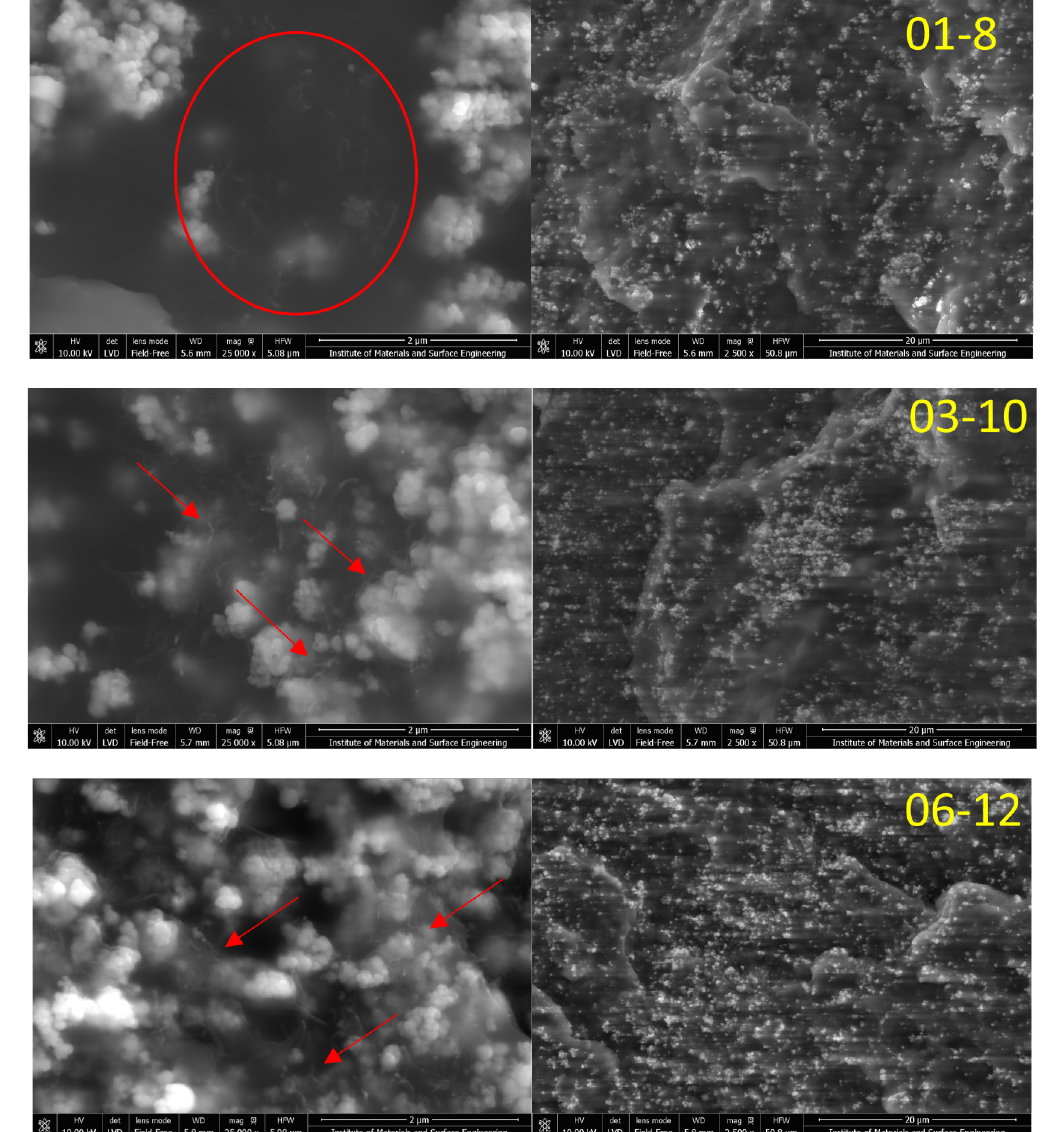
Figure 1. SEM micrographs for the selected nanocomposites using 2500 × and 25,000 × magnification. Arrows indicate cases of clearly distinguishable separate